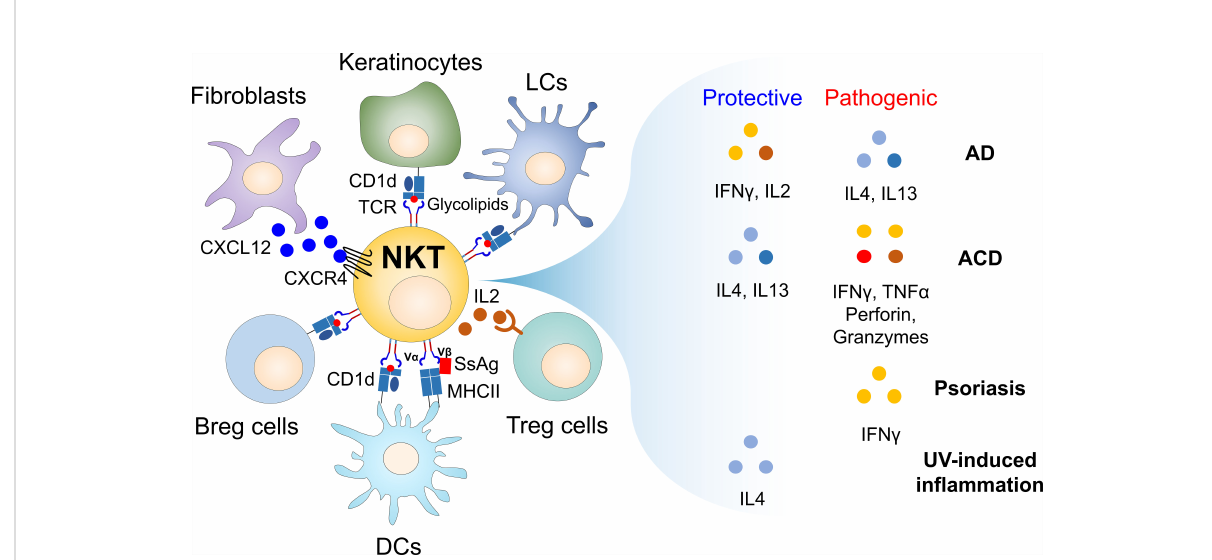
FIGURE 1 Cellular networks of CD1d-restricted NKT cells and their soluble factors in regulating skin in fl ammatory responses. Since the skin is constantly exposed to external stimuli such as pathogens and allergens, in fl ammatory immune responses occur when the skin barrier is broken.